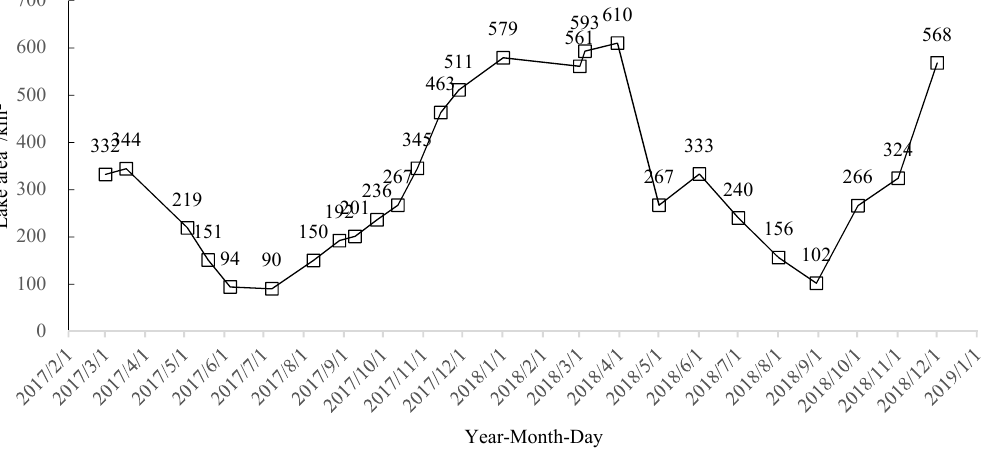
Figure 10. Variation curve of water surface area of intra ‐ annual of Taitema Lake.